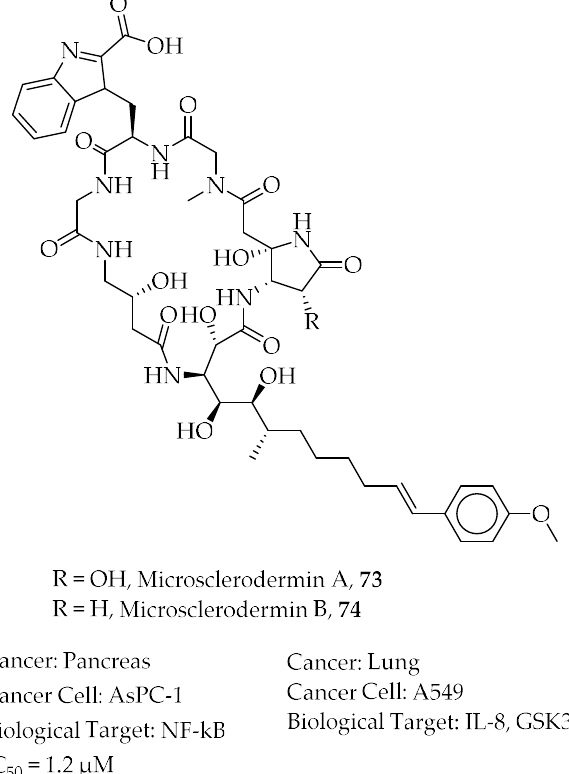
Figure 9. Chemical structures of Microsclerodermin A and B with a summary of their biological activity towards selected cancer targets.